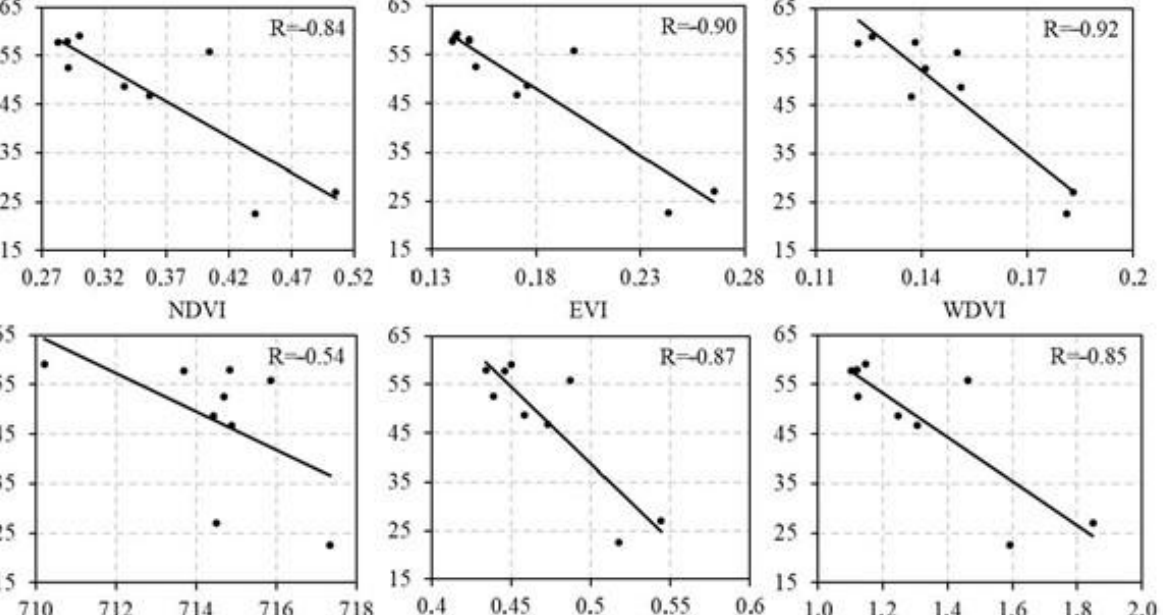
Figure 5. Sensitivity Analysis between Remote Sensing Indices and Crop Yield in the tillering stage (22 December 2020).